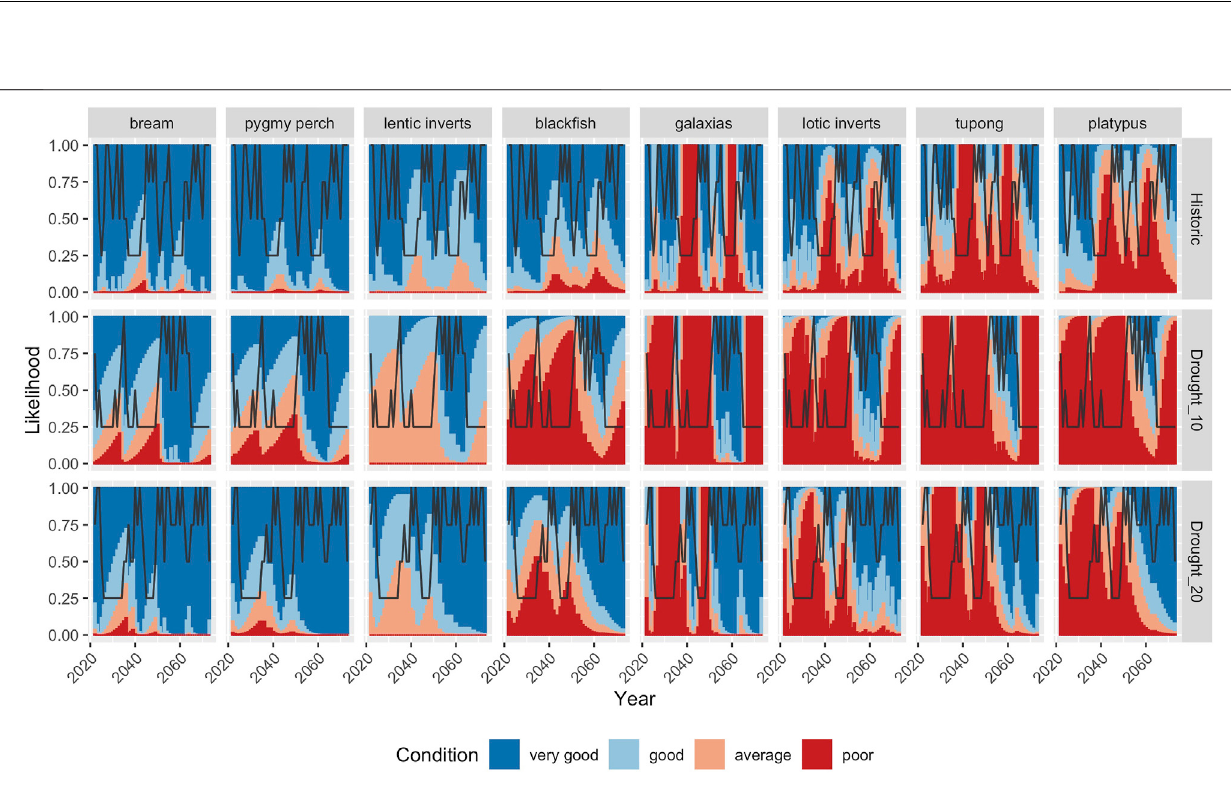
Frontiers in Environmental Science |